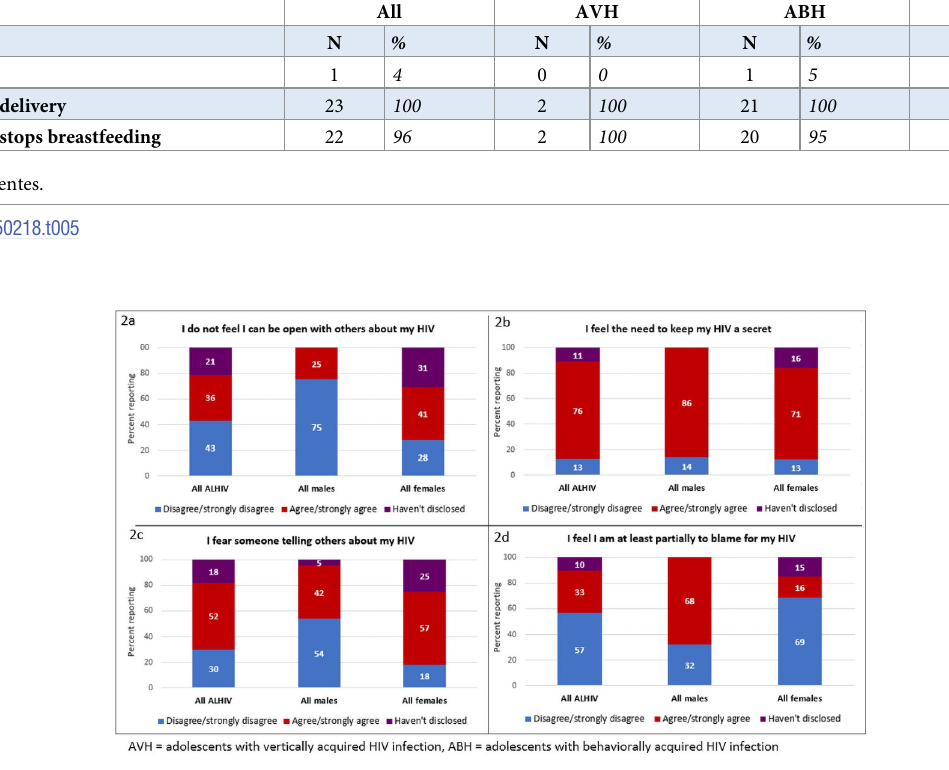
Fig 2. a-d. Responses to items on the Social Impact Scale from Mozambican ALHIV 15–19 years by sex and mode of HIV infection (N =